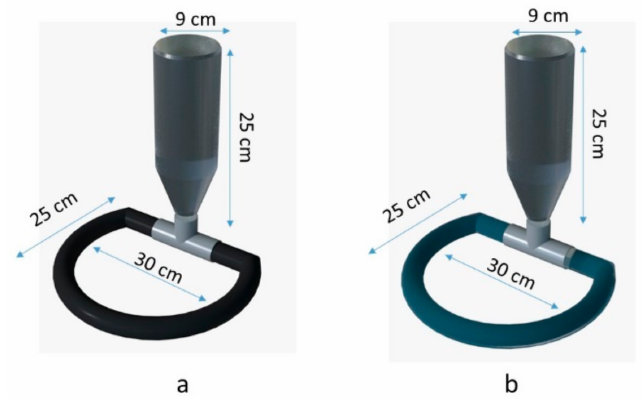
Figure 3. The pocket fertigation design: ( a ) emitter with textile coating (PT), ( b ) emitter without coating